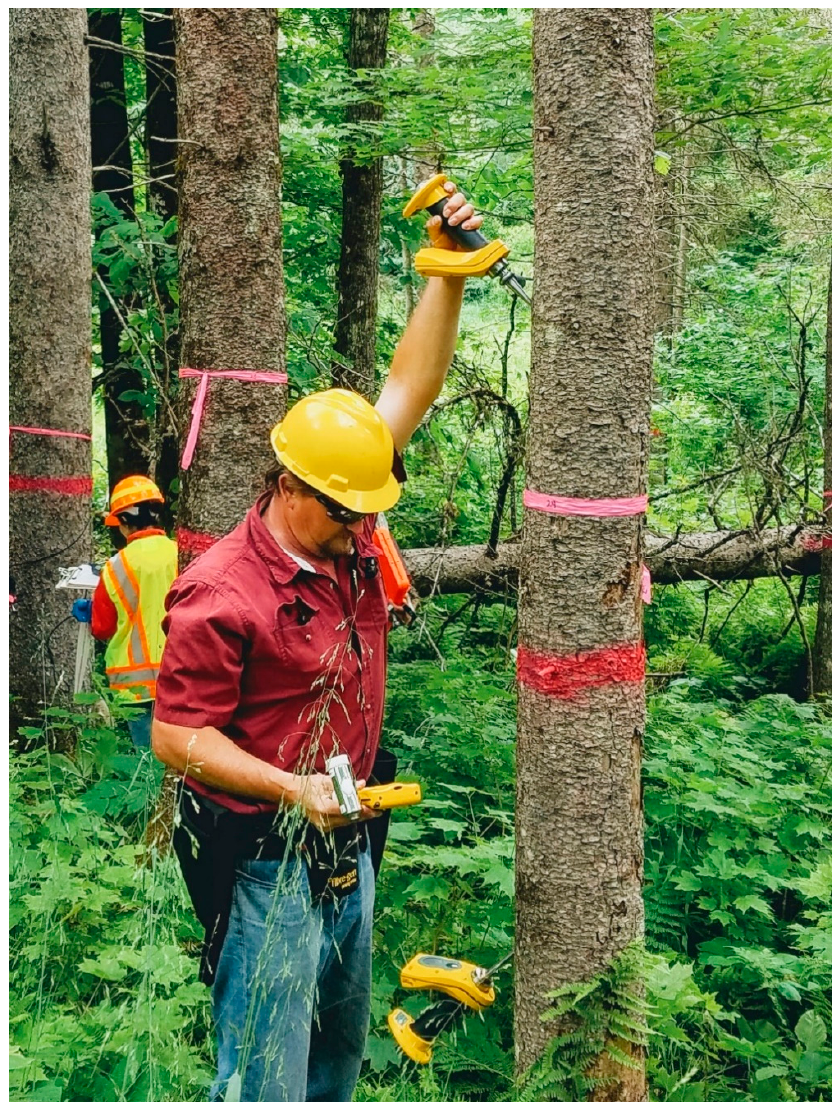
Figure 2. A portable time of flight (TOF) acoustic tool for measuring acoustic velocity (AV) in standing trees (photo credit: Xiping Wang).